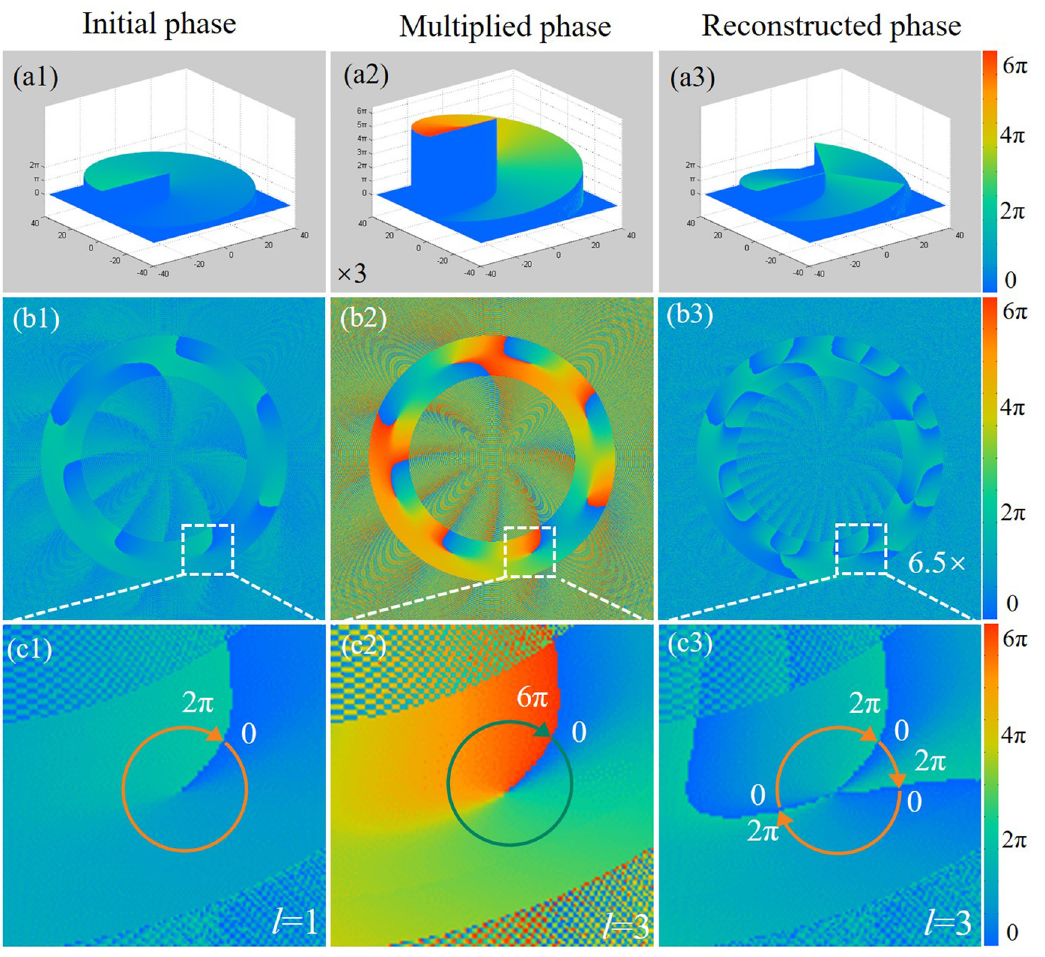
Figure 2: HO-TC generation via phase multiplication. (a1) – (a3) Initial, multiplied, and HO phases of OV, respectively. (b1) – (b3) Phase reconstruction of OVL. (c1) – (c3) Magnification patterns of the specific OV phase.